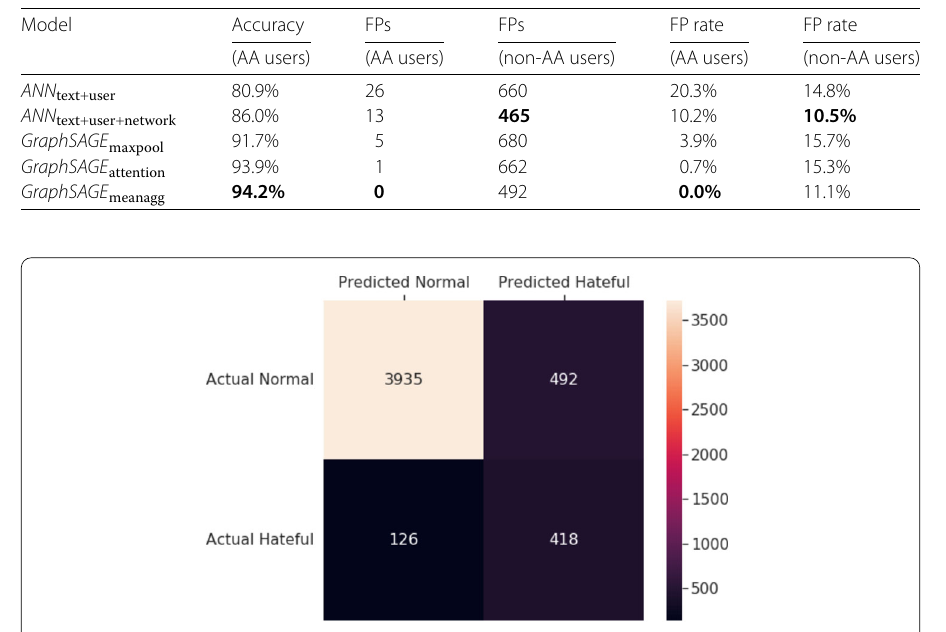
Figure 1 Confusion matrix. Predictions from best performing model: GraphSAGE with mean